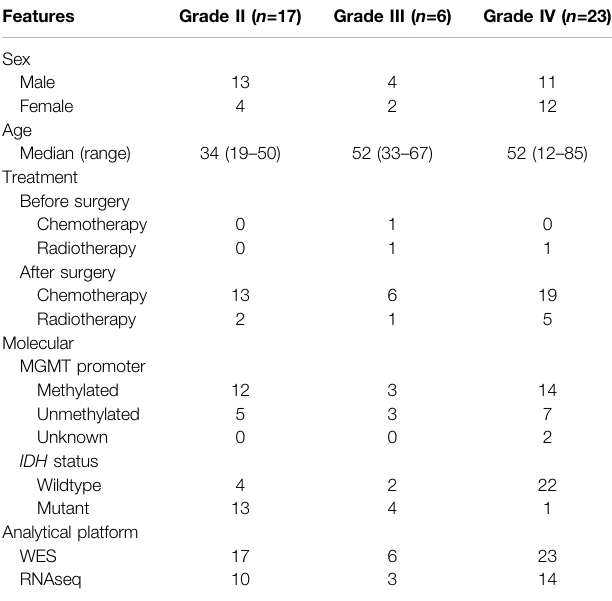
TABLE 1 | Patient distribution with different grades and clinical